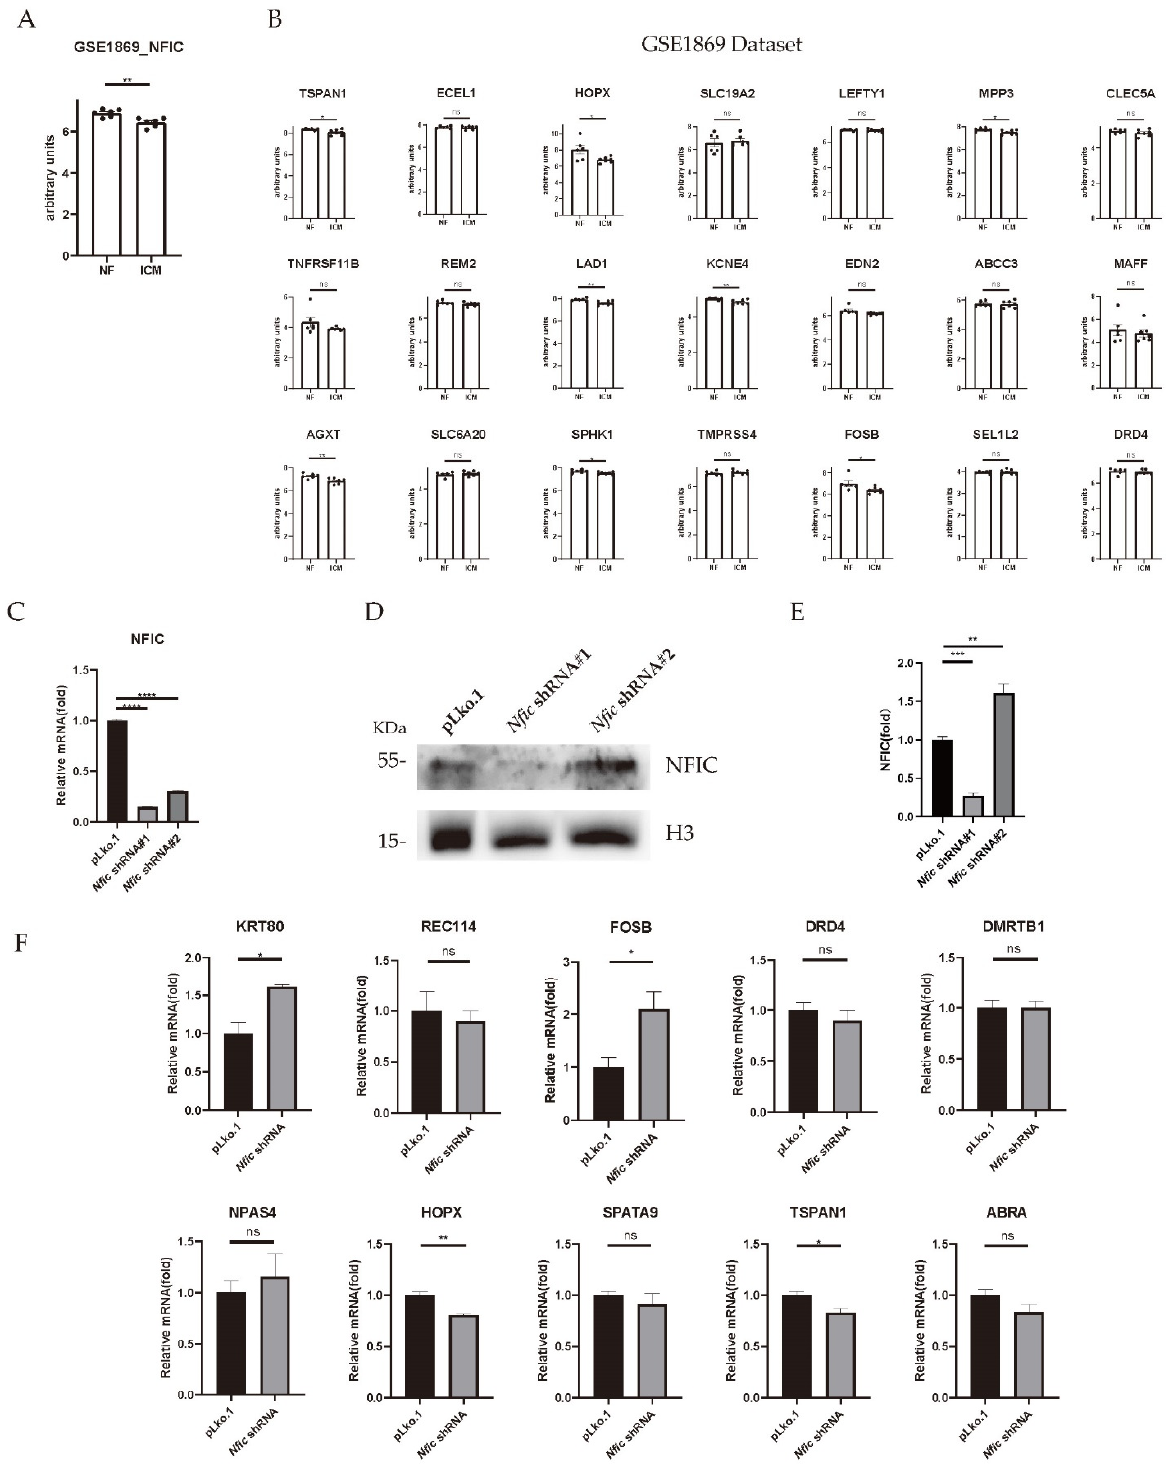
Figure 4. Verification of predicted genes with NFIC-binding motif. ( A ) The expression of NFIC in the validating GSE1869 dataset. ( B ) Expression of predicted genes with an NFIC-binding motif in the validating GSE1869 dataset. ( C ) The mRNA expression level of Nfic in H9C2 cells. ( D ) Western blot analysis of NFIC in H9C2 cells. ( E ) Quantification of the expression of NFIC in H9C2 cells. ( F ) The mRNA expression level of predicted genes in Nfic knockdown H9C2 cells ( n = 3 per group). * p value < 0.05; ** p value < 0.01; *** p value < 0.001; **** p value < 0.0001; NF, normal heart tissue; ICM, heart tissue of ischemic cardiomyopathy patient; ns: no